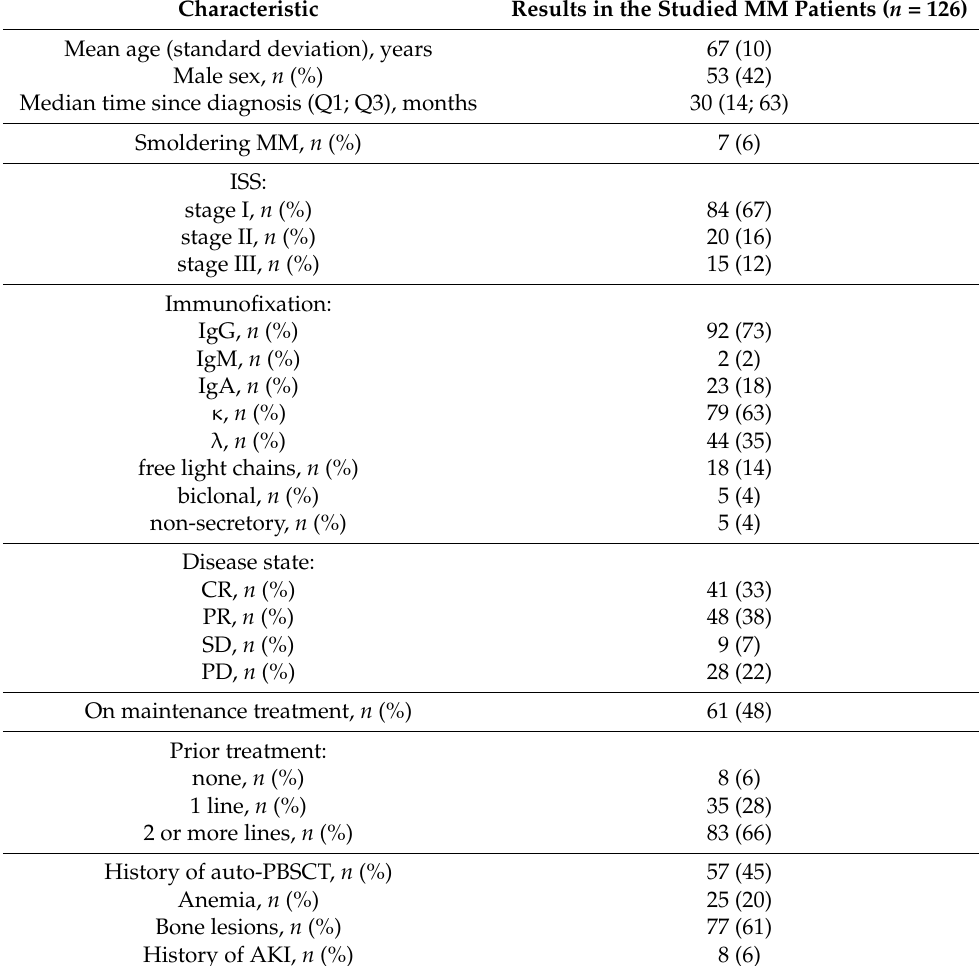
Table 1. Baseline clinical characteristics of the study